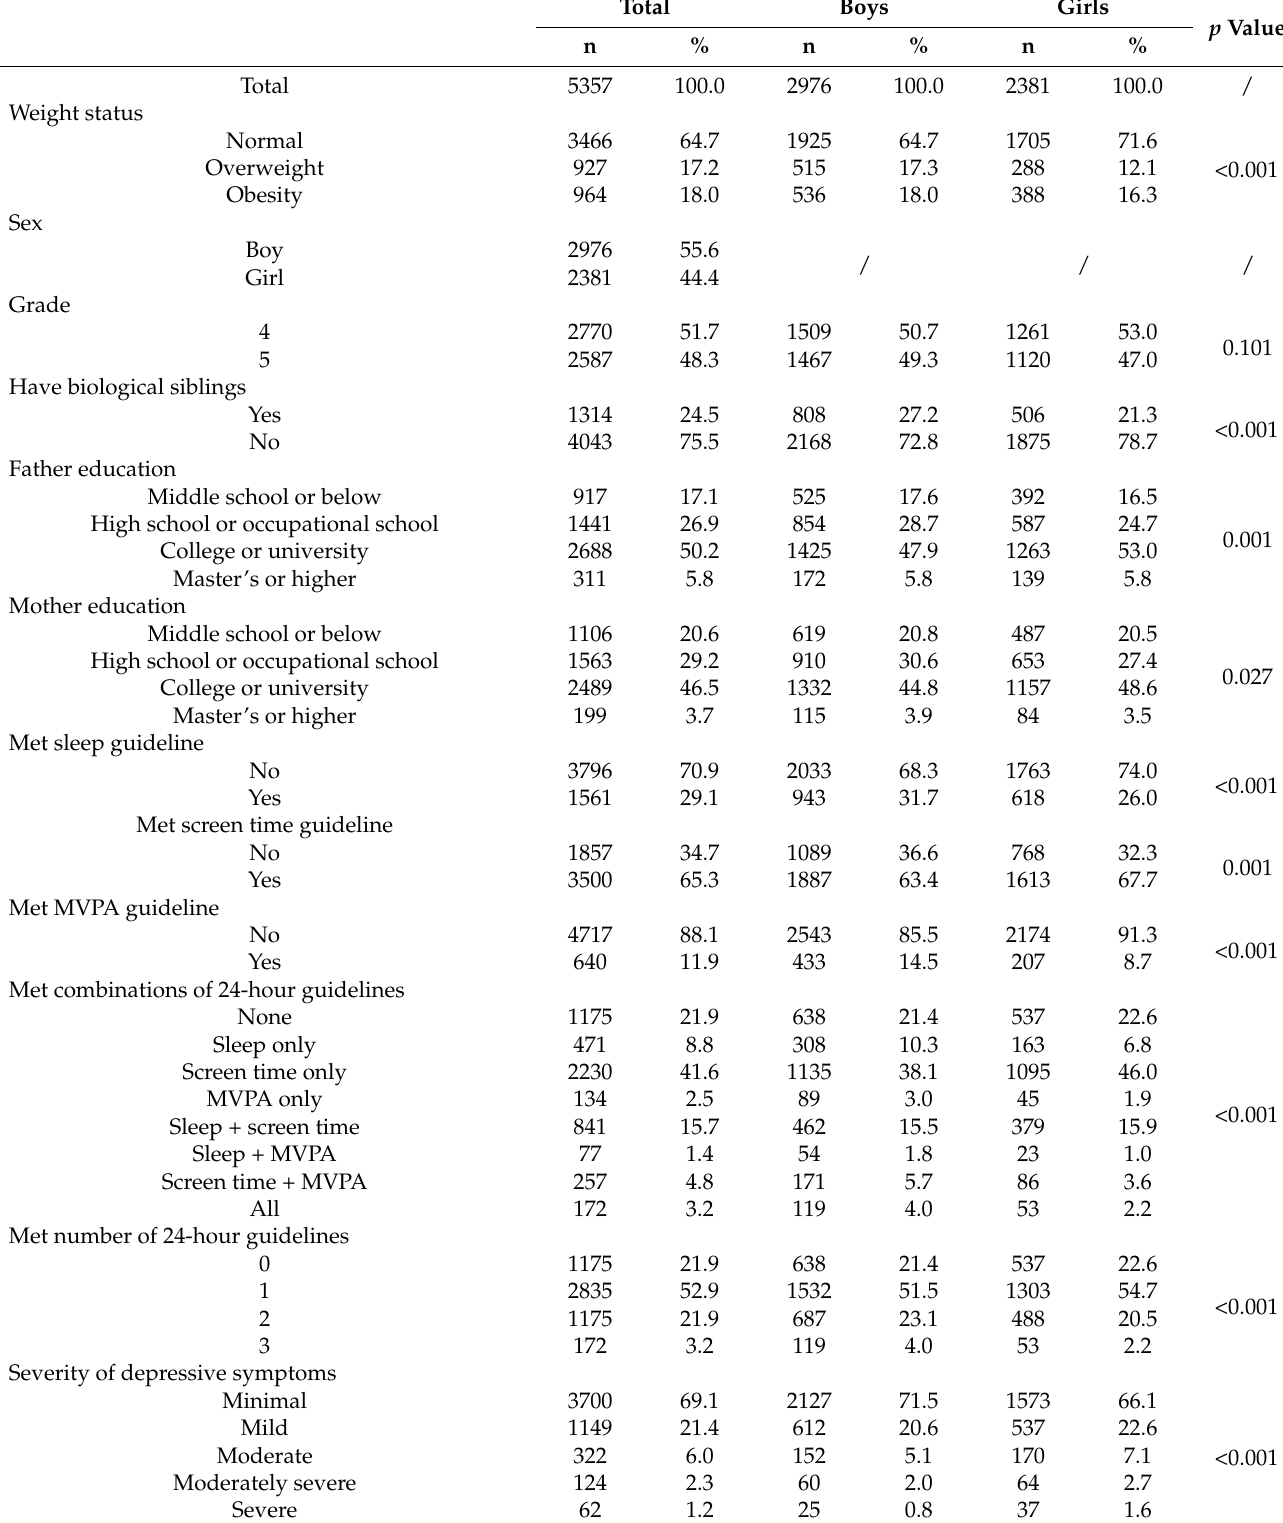
Table 1. Participant characteristics of this